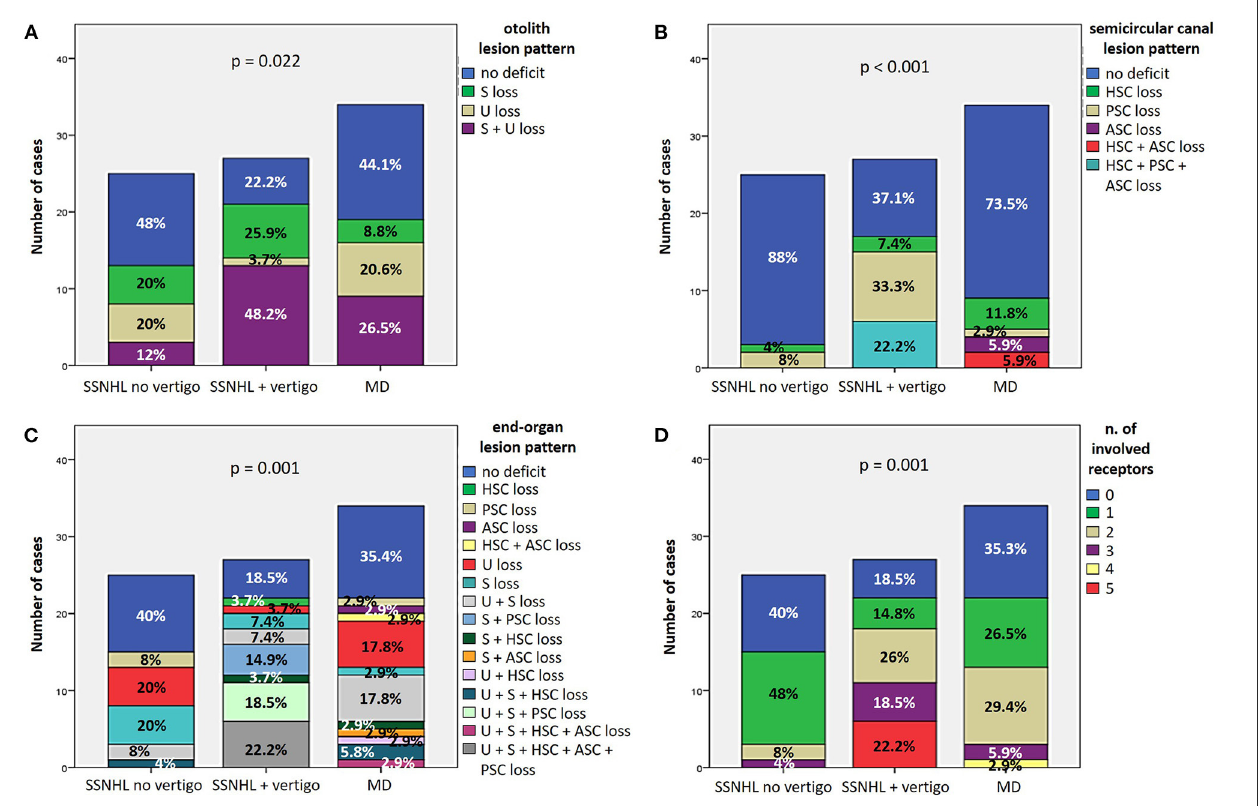
FIGURE5 (A , B) Bar plots showing the different distribution of otolith (A) and semicircular canal (B) lesion patterns among different subgroups based on clinical course. Relative percentages are reported in each column and p -values of categorical comparisons are reported. (C, D) Bar plots showing the different distribution of end-organ lesion patterns (C) and the amount of impaired vestibular receptors (D) among different subgroups. Relative percentages are reported in each column and p -value of categorical comparisons is reported. ASC, anterior semicircular canal; HSC, horizontal semicircular canal; MD, Menière’s disease; PSC, posterior semicircular canal; S, sacculus; SSNHL, sudden sensorineural hearing loss; U, utriculus.